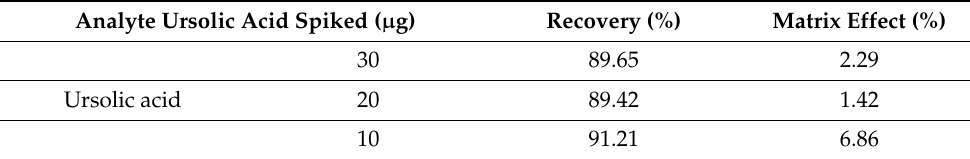
Table 6. Recovery and matrix effect of UA.